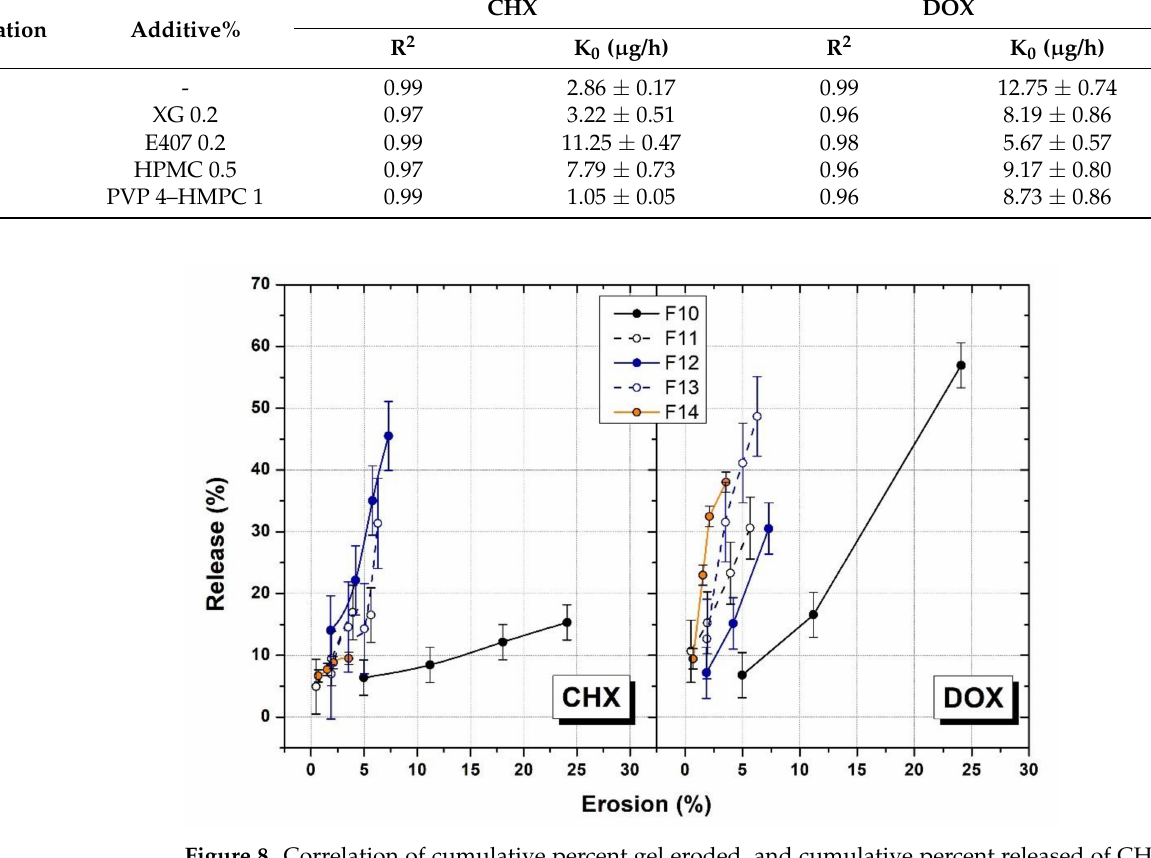
Figure 8. Correlation of cumulative percent gel eroded, and cumulative percent released of CHX and